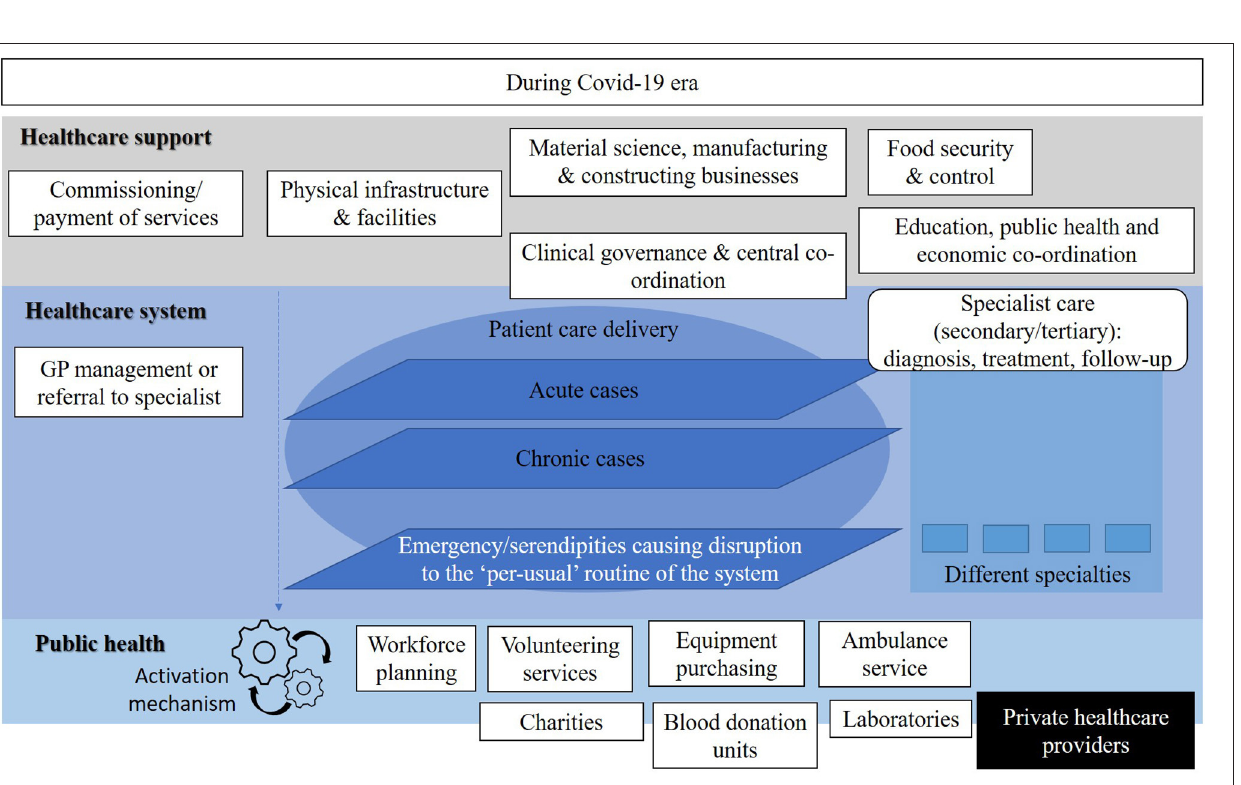
Frontiers in Public Health | www.frontiersin.org